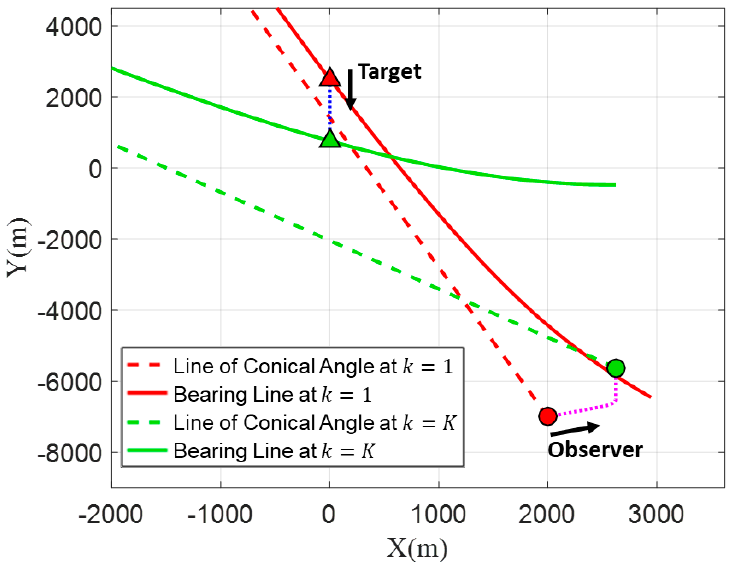
and . Figure 6. Bearing lines (solid lines) and lines of conical angles (dashed lines) at k = 1 and k = K 𝑘𝑘 = 1 𝑘𝑘 = 𝐾𝐾